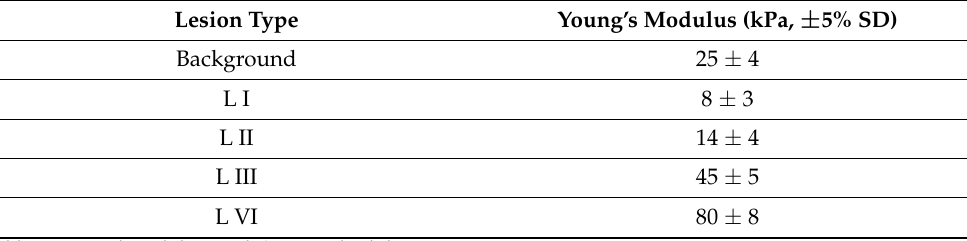
Figure 1. Computerized Imaging Reference Systems. Elasticity quality assurance phantom. Phantom Model-049. Norfolk, VA: Computerized Imaging Reference Systems, 2016. Available from: https://www.cirsinc.com/wp-content/uploads/2020/03/049-049-DS-030920.pdf (accessed on 10 May 2022) [21]. Table 1. Manufacture elasticity measurements of background and lesions within the phantom.